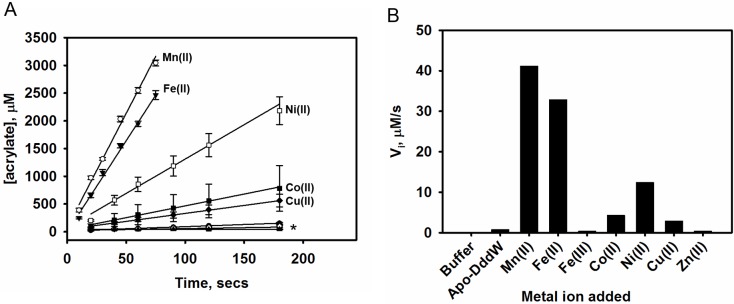
Effects of various transition metal ions on the DMSP lyase activity of DddW.All metal ions were added so that they were at least 90% bound (the calculations were based on the Kd of individual metal ions). Assays were performed anaerobically at pH 8.0 and room temperature. The activity of Apo-DddW without metal ions was used as a reference (100%). (A) Determination of the initial velocity (Vi) of DddW catalyzed reaction in presence of various transition metal ions: Mn(II), Fe(II), Fe(III), Co(II), Ni(II), Cu(II), and Zn(II). For clarity, plots of Fe(III), Zn (II), apo-DddW, and buffer control are indicated by ‘*’. (B) Effect of metal ions on the initial velocity (Vi) of DddW catalyzed lyase reaction.